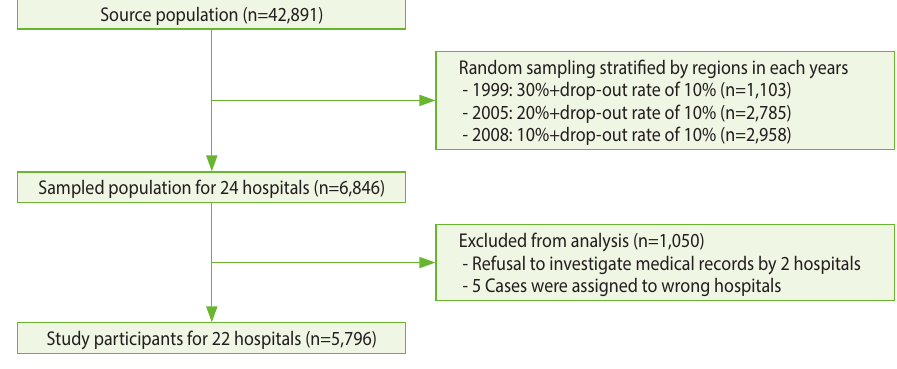
Figure 3. Flow chart for study participant